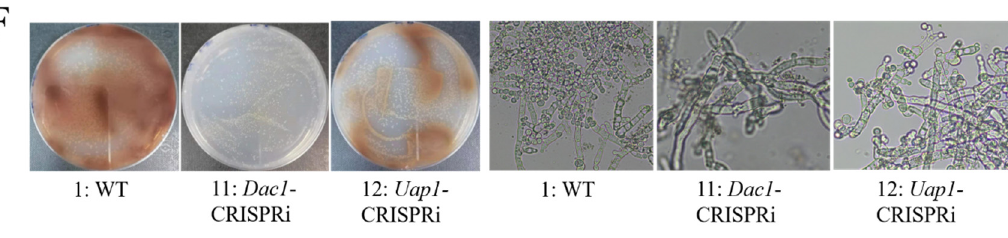
Figure 4. The construction of CRISPRi on conidia and GlcNAc metabolic pathway genes in Aspergillus niger SH2. ( A ) The GlcNAc metabolic pathway in Candida albicans. The red font denotes relevant genes. ( B ) Diagram of the CRISPRi working principle and the map of CRISPRi system in this study. In this study, the CRISPRi system consisted of d Cas9 - Mxi1 expression cassette and sgRNA expression cassette. The d Cas9 - Mxi1 expression cassette was assembled into a pFC330 plasmid. However, the sgRNA expression cassette was inserted into the genome of Aspergillus niger SH2 ( aamA gene locus). ( C ) The phenotype of the Aspergillus niger SH2 transformants on NCD plates, where 1 WT means Aspergillus niger SH2 wild strain, 2 d Cas9 - Mxi1 only means the transformant for which only the pFC330-d Cas9 - Mxi1 vector was transferred into Aspergillus niger SH2, 3 d Cas9 only1 means the transformant No. 1 for which only the pFC330-d Cas9 vector without Mxi1 was transferred into Aspergillus niger SH2, 4 d Cas9 only2 means the transformant No. 2 for which only the pFC330-d Cas9 vector without Mxi1 was transferred into Aspergillus niger SH2, 5 d Cas9 + sgRNA without spacer RNA means the transformant for which the pFC330-d Cas9 - Mxi1 vector and linearized sgRNA general vector, without spacer RNA, were simultaneously transferred into Aspergillus niger SH2, 6 hfbD-CRISPRi means the transformant for which the pFC330-d Cas9 - Mxi1 vector and linearized hfbD sgRNA general vector were simultaneously transferred into Aspergillus niger SH2, 7 GC-CRISPRi means the transformant for which the pFC330-d Cas9 - Mxi1 vector and linearized GC sgRNA general vector were simultaneously transferred into Aspergillus niger SH2, 8 Hxk1-CRISPRi means the transformant for which the pFC330-d Cas9 - Mxi1 vector and linearized Hxk1 sgRNA general vector were simultaneously transferred into Aspergillus niger SH2, 9 H-MAPK1-CRISPRi means the transformant for which the pFC330-d Cas9 - Mxi1 vector and linearized H-MAPK1 sgRNA general vector were simultaneously transferred into Aspergillus niger SH2, 10 Ngt1-CRISPRi means the transformant for which the pFC330-d Cas9 - Mxi1 vector and linearized Ngt1 sgRNA general vector were simultaneously transferred into Aspergillus niger SH2, 11 Dac1-CRISPRi means the transformant for which the pFC330-d Cas9 - Mxi1 vector and linearized Dac1 sgRNA general vector were simultaneously transferred into Aspergillus niger SH2, and 12 Uap1 -CRISPRi means the transformant for which the pFC330-d Cas9 - Mxi1 vector and linearized Uap1 sgRNA general vector were simultaneously transferred into Aspergillus niger SH2. ( D ) qPCR analysis of the Aspergillus niger SH2 transformants. Samples 6, 7, 8, 9, 10, 11, and 12 are described as per ( C ). ( E ) Semi-quantitative RT-PCR of the Aspergillus niger SH2 transformants. Samples 1, 2, 3, 4, 5, 6, 7, 8, 9, 10, 11, and 12 are described as per ( C ). ( F ) The phenotype and micromorphology of the Aspergillus niger SH2 transformants on NCD plates. The * means p < 0.05.